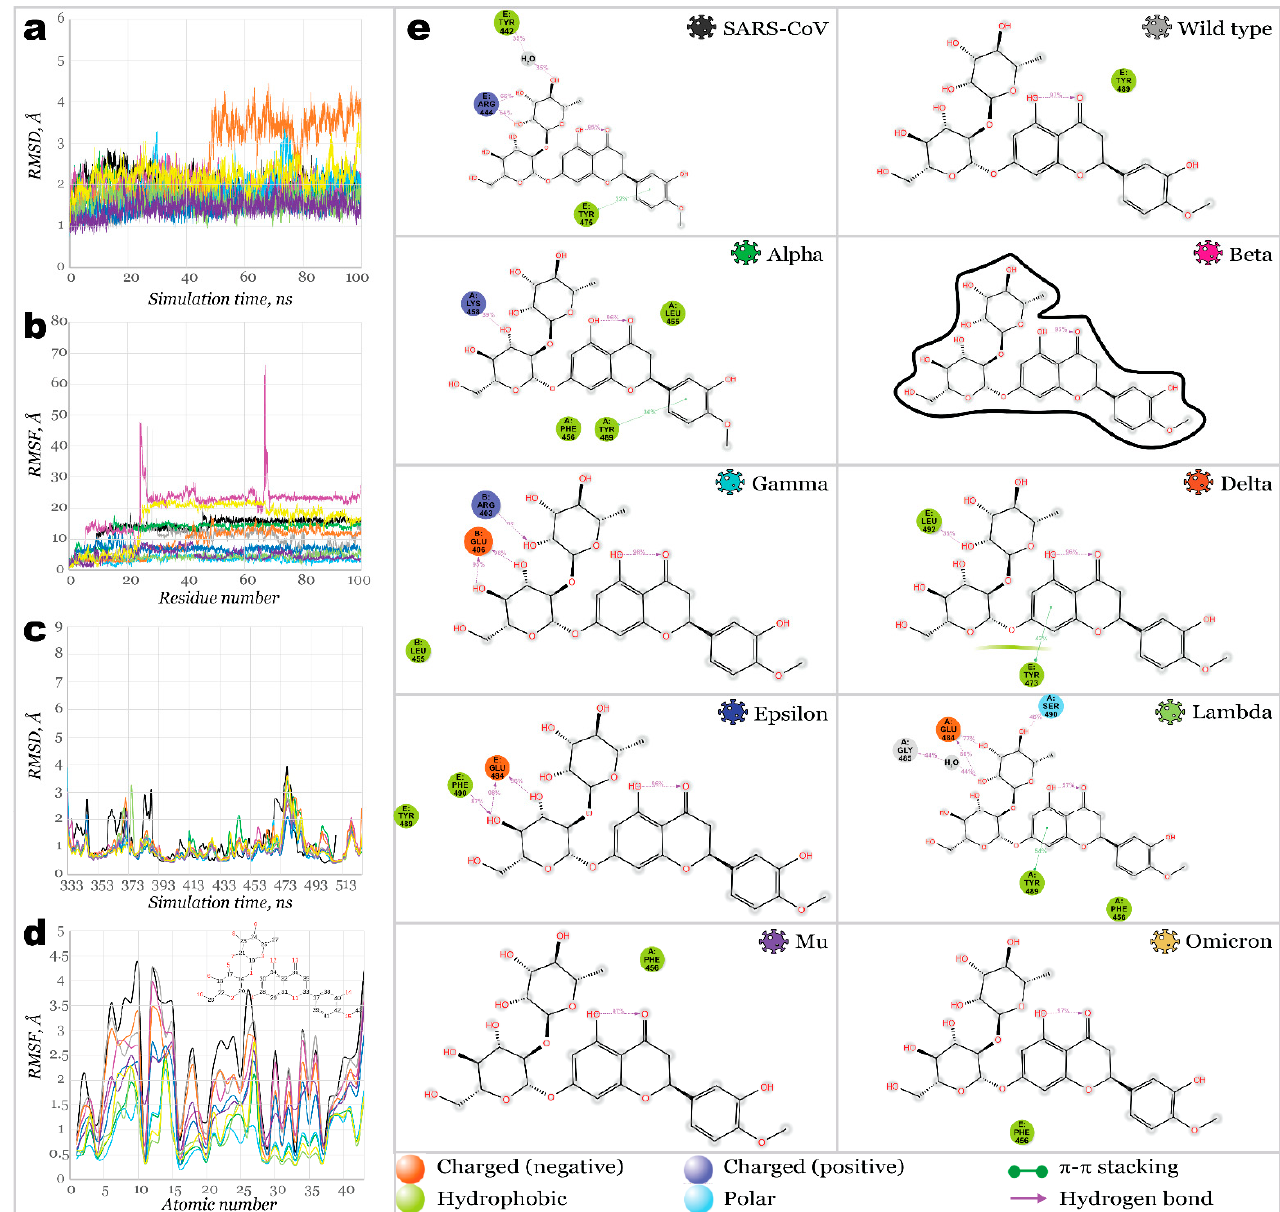
Figure 9. One hundred nanoseconds of MD simulations results for RBD- 39 (neohesperidin) com- plexes: ( a )—RMSD of protein’s Ca ; ( b )—RMSF of protein structures; ( c )—RMSD of ligand fit on protein; ( d )—RMSF of ligand’s structures; ( e )—2D interactions diagram for neohesperidin and RBDs.